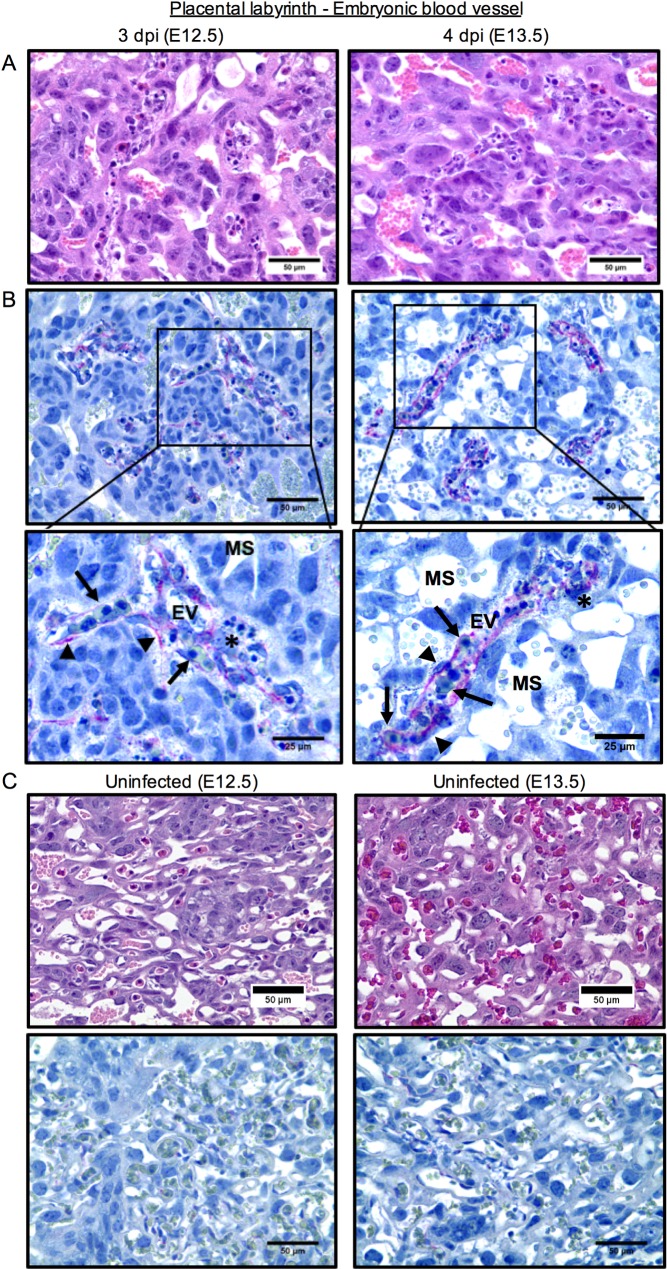
ZIKV antigen co-localizes with embryonic endothelial cells in the placental labyrinth and associates with damage.Pregnant dams at E9.5 were infected with 3.4 × 105 PFU of ZIKV and sacrificed at 3 and 4 dpi. Paraffin-embedded placental tissues were stained with H&E (A and C) or ZIKV E protein (red) with hematoxylin counterstain (blue) (B and C). Representative images of the embryonic blood vessels in the placental labyrinth are shown. (A) Necrosis within the embryonic blood vessels. (B) ZIKV antigen was detected within the embryonic endothelial cells in embryonic blood vessels of the placental labyrinth. Arrows indicate nucleated embryonic red blood cells. Arrowheads indicate the staining of ZIKV antigen and highlight morphology of infected cells and antigen staining pattern. Asterisks indicate areas of necrotic cell debris. (C) Tissues from uninfected dams at the same gestational age were used as negative controls. MS, maternal sinus; EV, embryonic blood vessel. Scale bar, 50 μm or 25 μm.